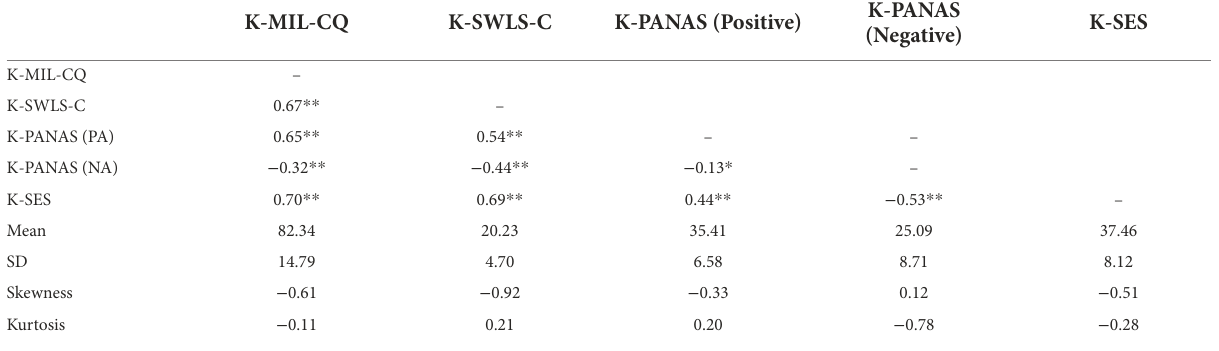
TABLE 1 Correlation values between measures, means, standard deviations, skewness, and kurtosis.